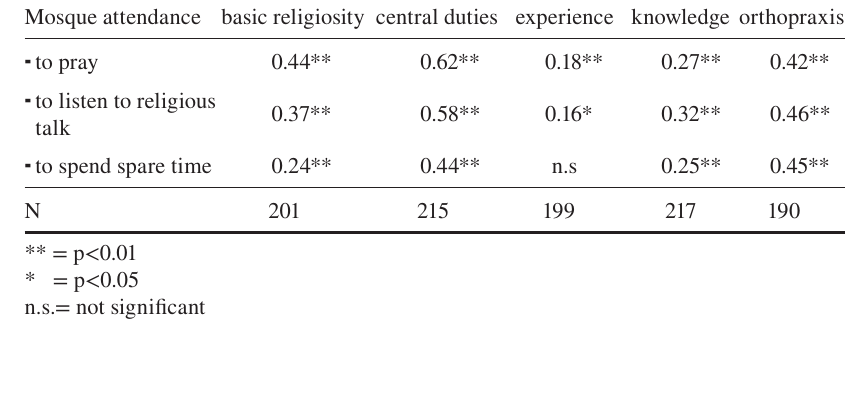
Table 9 : Correlations of the five dimensions of religiosity and Mosque attend- ance (Pearsons